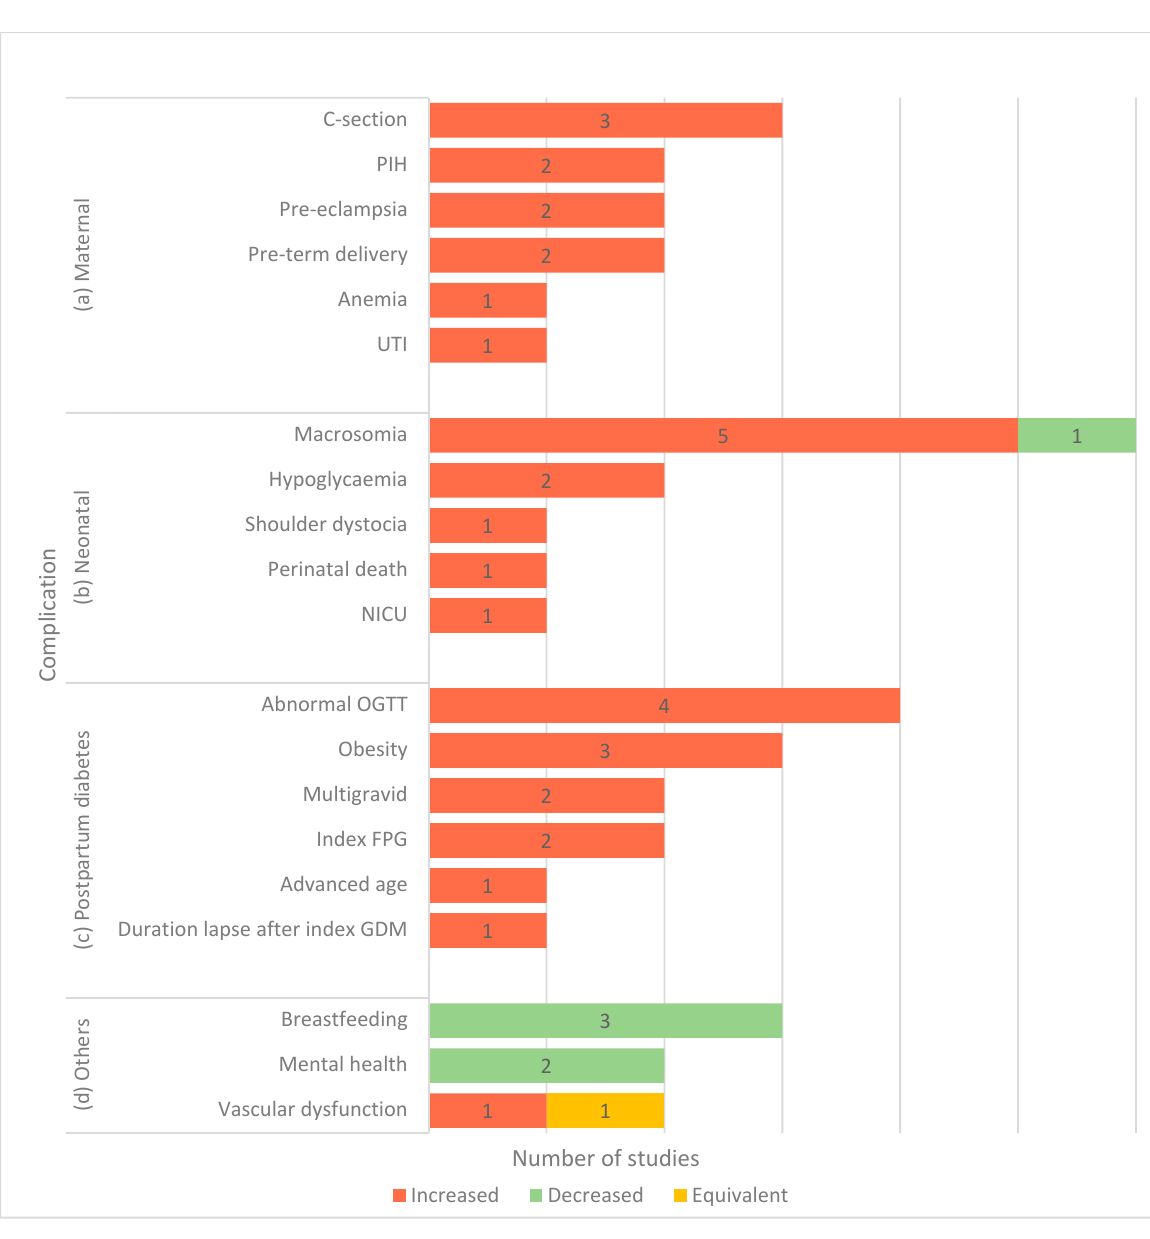
Figure 6. Factors associated with the complication of GDM. Note: Several influencing factors were studied under the subdomains of maternal outcomes ( a ), neonatal outcomes ( b ), postpartum diabetes ( c ), and other complications ( d ). Dec: decreased risk/incidence of complications, Inc.: increased risk/incidence of complications, and Equ: equivocal/no association. HbA1c: glycated hemoglobin, PIH: pregnancy-induced hypertension, UTI: urinary tract infection, NICU: neonatal intensive care unit, Index FPG: index fasting plasma glucose, BV dysfunction: blood vessel dysfunction, and OGTT: Oral Glucose Tolerance Test.